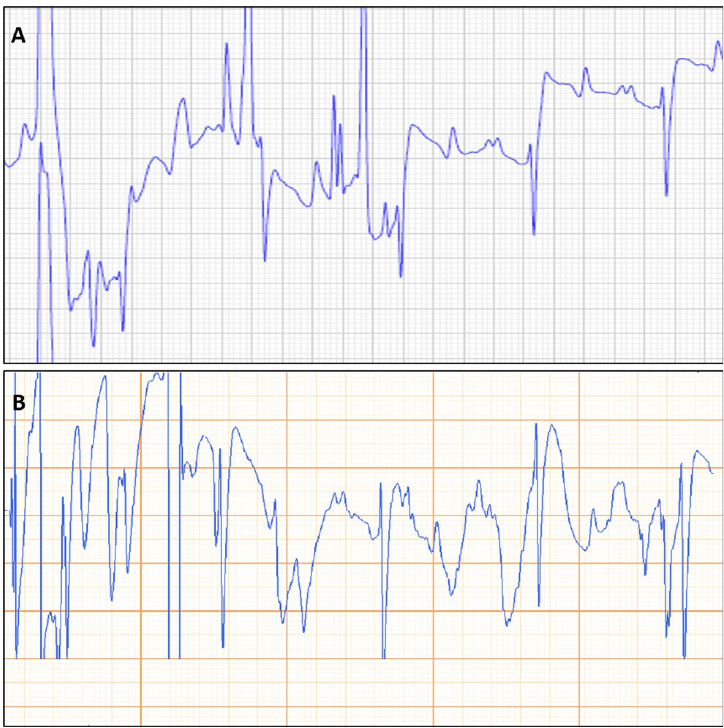
Fig 5. Side-by-side example of a tracing with baseline artifacts obtained simultaneously with reference ECG (rECG; A) and smartphone ECG (spECG; B). Paper speed = 25 m/s; 10 mm/mV.